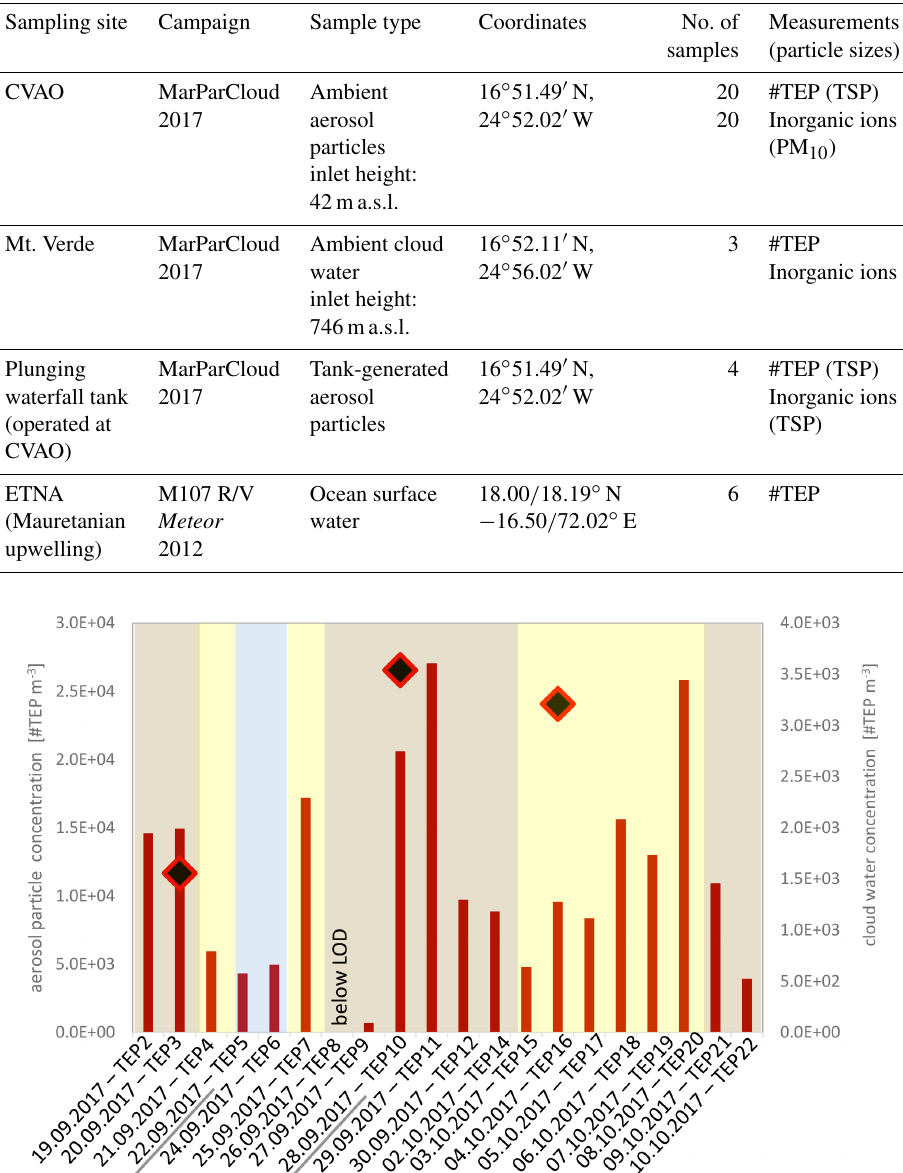
Figure 2. Transparent exopolymer particle (TEP) number concentrations in the aerosol particles (red bars) and in the three cloud water samples (black-red squares). TEP concentrations were below the limit of detection (LOD) on 26 September 2017. The backgrounds represent the dust classification according to the ambient dust concentrations (blue: dust <5µgm − 3 marine conditions; yellow: dust < 20µgm − 3 low dust; brown: dust < 60µgm − 3 moderate dust). From underlined dates (22 September – > “TEP5” and 28 September 2017 – > “TEP10”) TEP number size distributions were